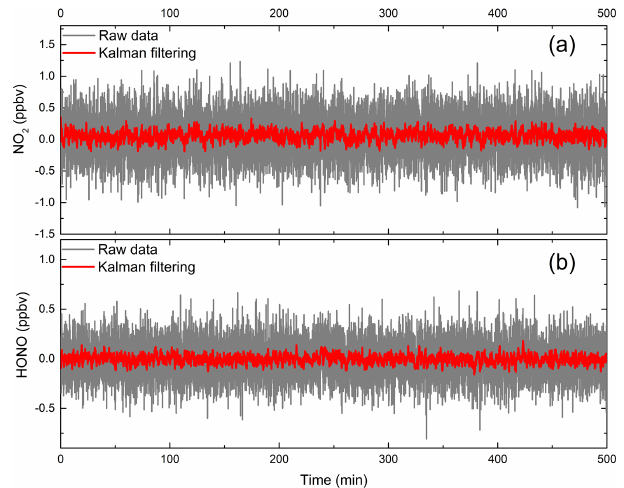
Figure 12. The measurement results for (a) HONO and (b) NO 2 with and without Kalman filtering under zero-air conditions. The red line is the concentration result after processing with Kalman filtering technology, and the grey line is the result for the original concentration